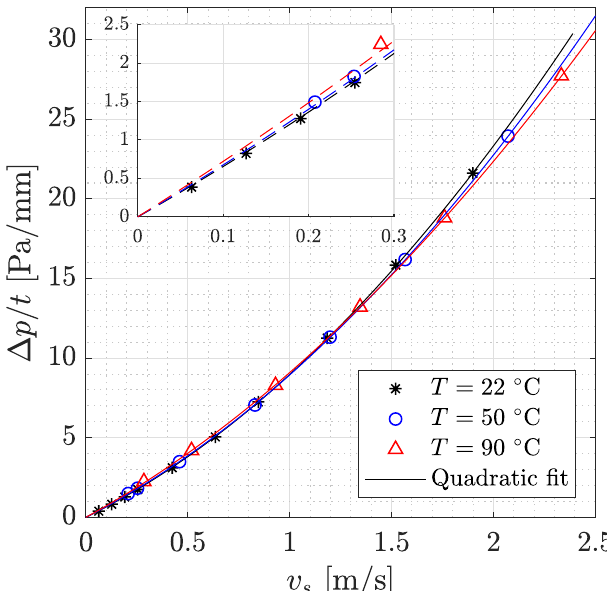
Figure 5. Change in normalized pressure drop along porous samples with t = 6cm due to changing fluid temperatures. Quadratic curve fitting is indicated by the dashed lines and a magnification of the linear flow region is provided.